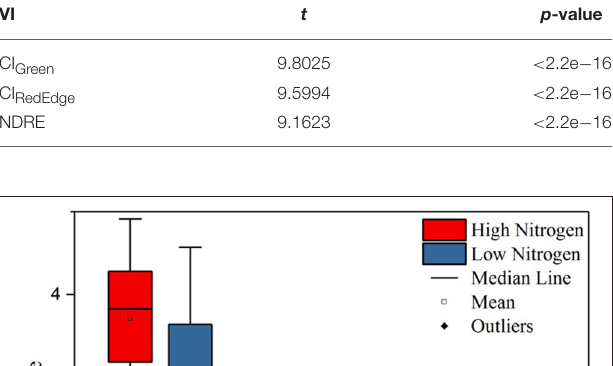
TABLE 7 | Pearson correlation coefficients between the chlorophyll and nitrogen contents of leaf samples, and the corresponding VIs of same plots calculated from multispectral aerial data and leaf-level hyperspectral measurements, using data set collected over three flights in